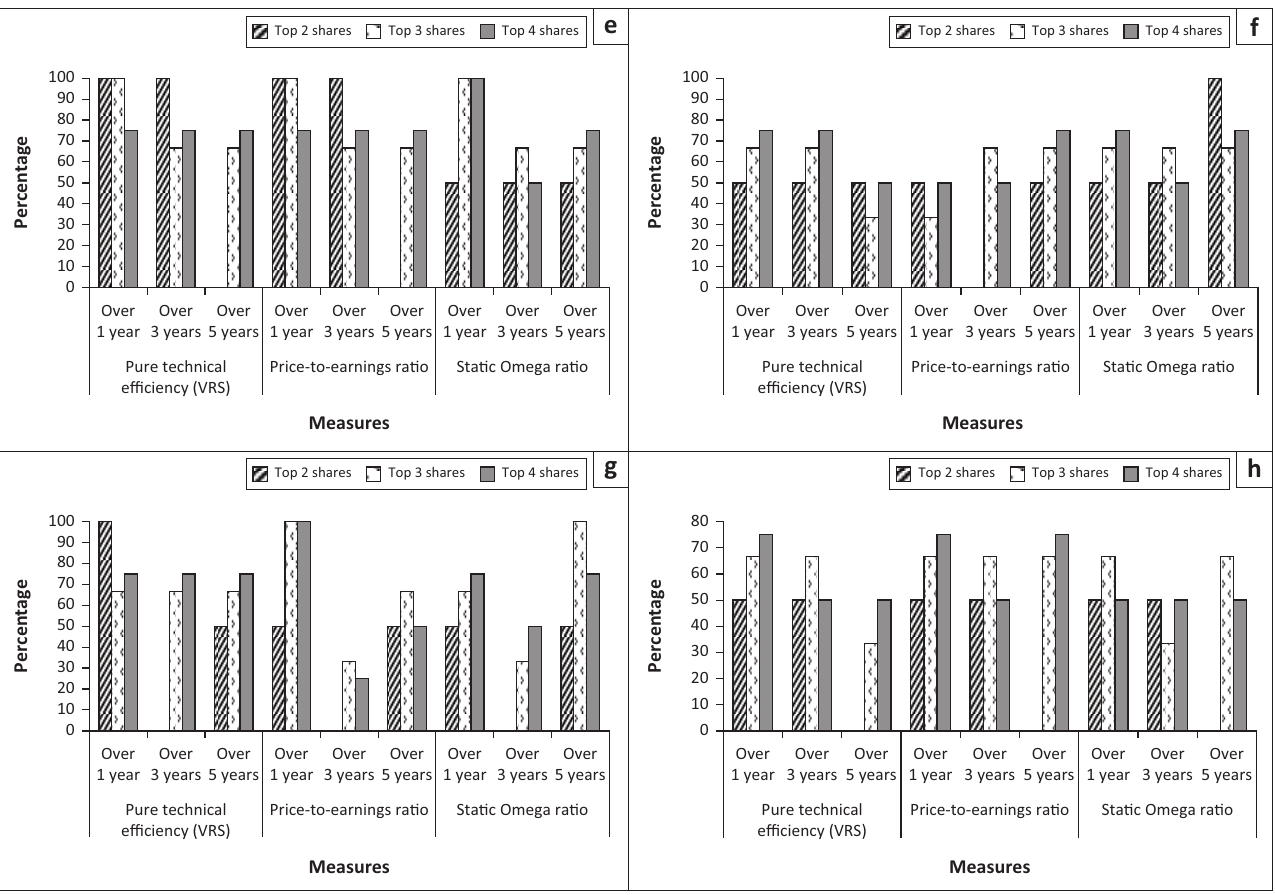
FIGURE 2 (Continues...): Average ability of pure technical efficiency (VRS), the P/E ratio and static Omega ratio to select the top performing banking shares: (a) 2004; (b) 2005; (c) 2006; (d) 2007; (e) 2008; (f) 2009; (g) 2010 and (h)